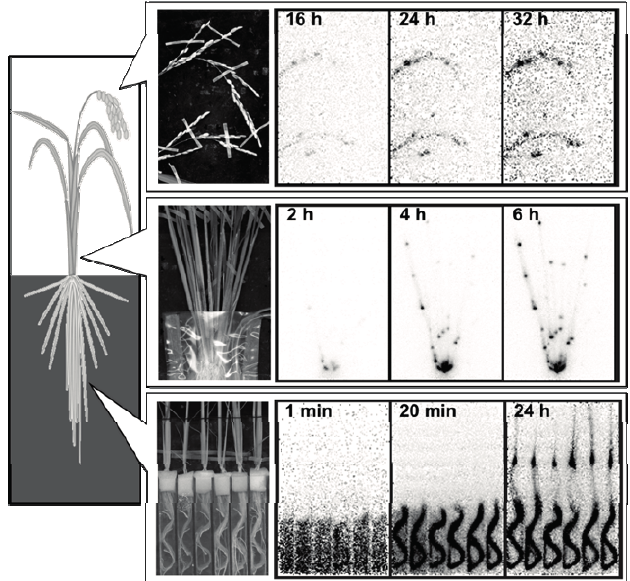
Figure 8. Movement of 107 Cd in rice plants administered from the root–bathing solution visualized with a positron-emitting tracer imaging system (PETIS). Regenerated from the original data of Ishikawa et al. [38] and Fujimaki et al. [62]. Important note: The images show the uptake and accumulation of 107 Cd by roots, transport to the shoots accompanying accumulation at the nodes (probably occurring during xylem-to-phloem transport), and final destination in the